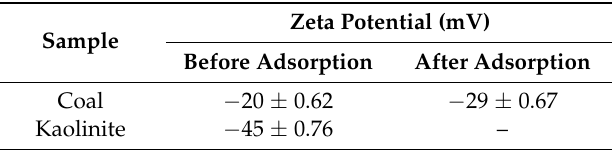
Table 6. Zeta potential of coal and kaolinite with adsorption of PAM A401 (12 mg/L). Zeta Potential (mV) Sample Before Adsorption After